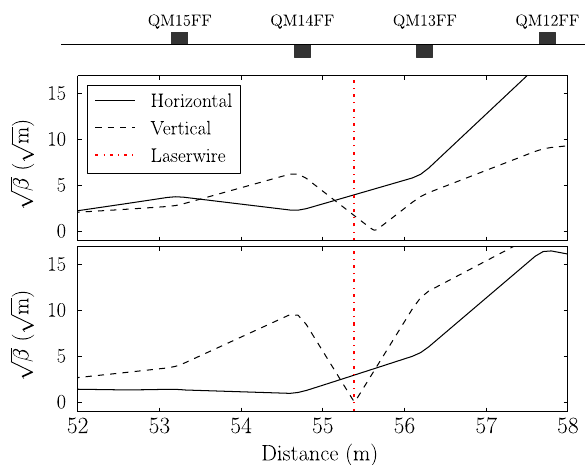
FIG. 4. Electron beam amplitude functions about the laserwire interaction point for normal ATF2 operation (top) where the vertical waist is located at the MFB2FF cavity BPM, and for laserwire operation (bottom), where the waist is moved to the laserwire